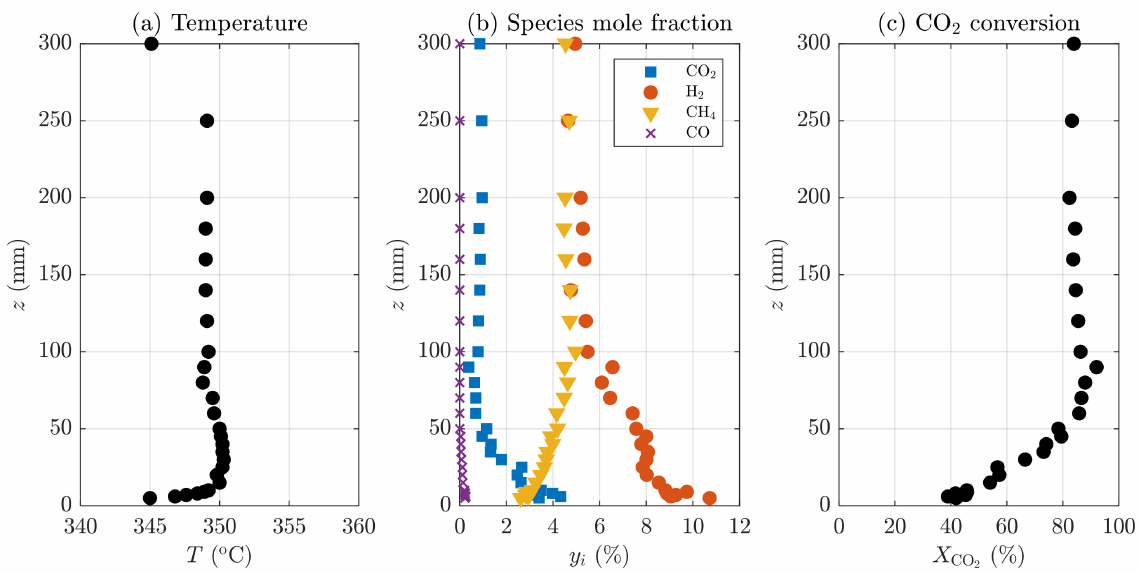
Figure 6. ( a ) bed temperature, ( b ) gas concentration, and ( c ) CO 2 conversion along the catalyst bed height in a bubbling fluidized bed at 1 bar and 340 ◦